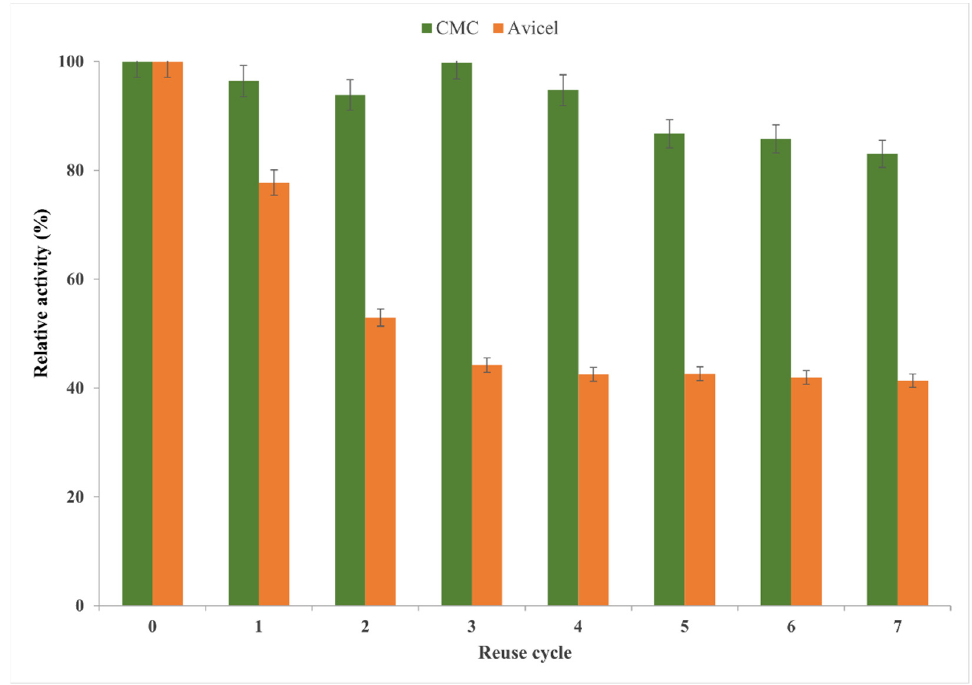
Figure 13. Operational stability of Cellic CTec2 cellulase that was immobilized by its entrapment in magnetic sol–gel (M1-SG9) with VTMOS:PhTMOS:TMOS (0.4:1.6:1) in the hydrolysis of CMC at 30 min reaction time at 50 °C, and Avicel PH-101 at 24 h reaction time at 50 °C.